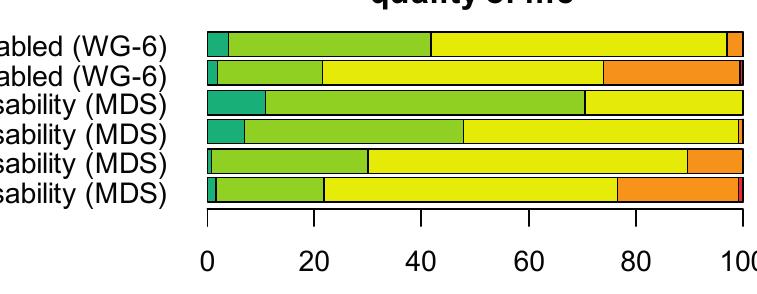
Figure 7. Comparison of the samples generated with the functioning screener approach and the WRD approach for quality of life. Dark green: very good; light green: good; yellow: neither poor nor good; orange: poor; red: very